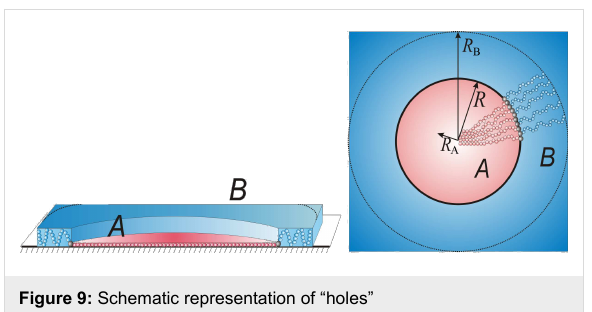
Figure 9: Schematic representation of